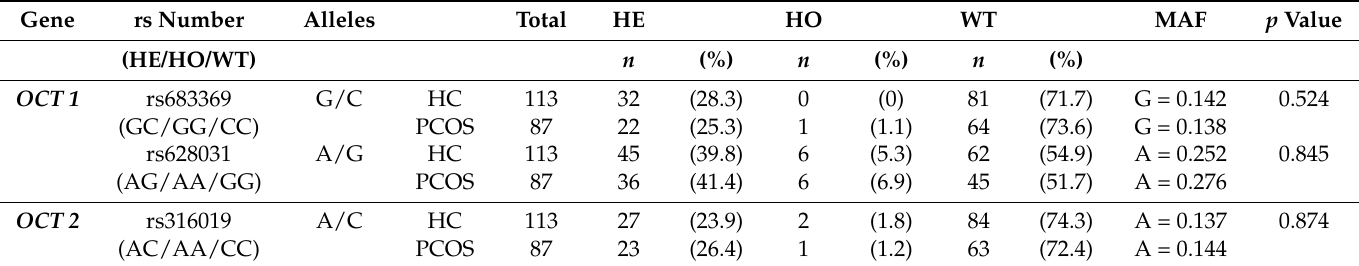
Table 4. Oral glucose tolerance test (OGTT) parameters before and after metformin treatment, subgrouped by genotypes of OCT1 and OCT2.